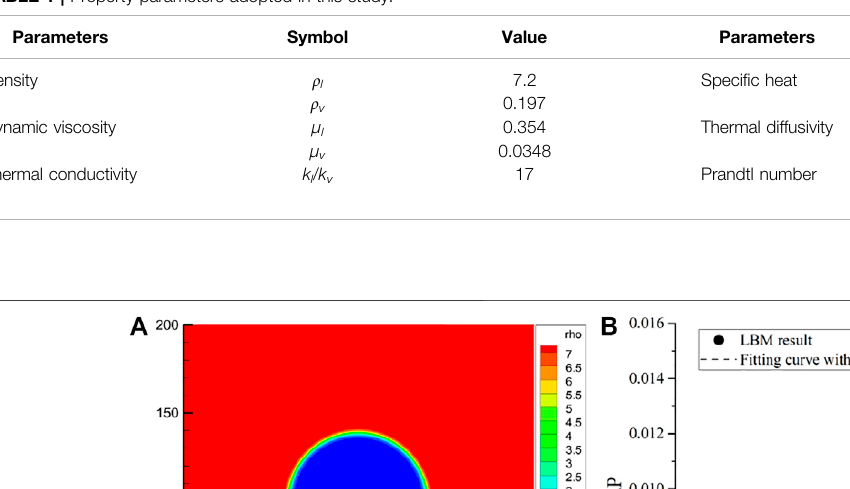
TABLE 1 | Property parameters adopted in this study.